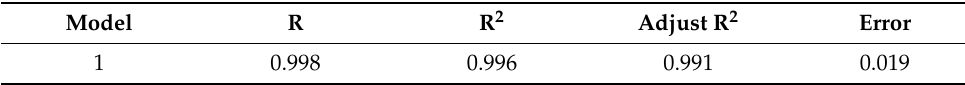
Table 3. Collinearity analysis R 2